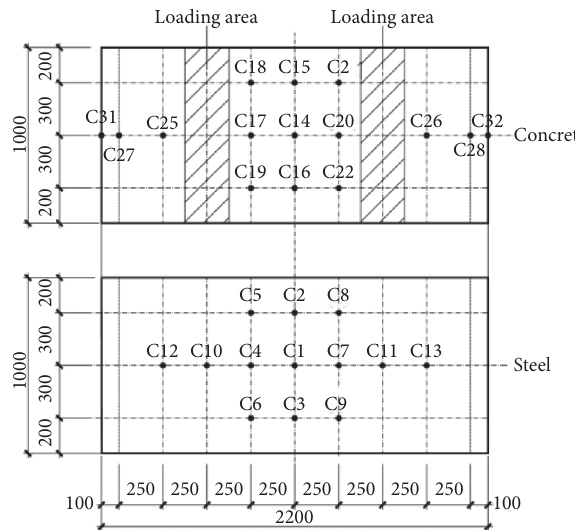
Figure 9: Vertical displacement measurement points arrangement of flexural experiment